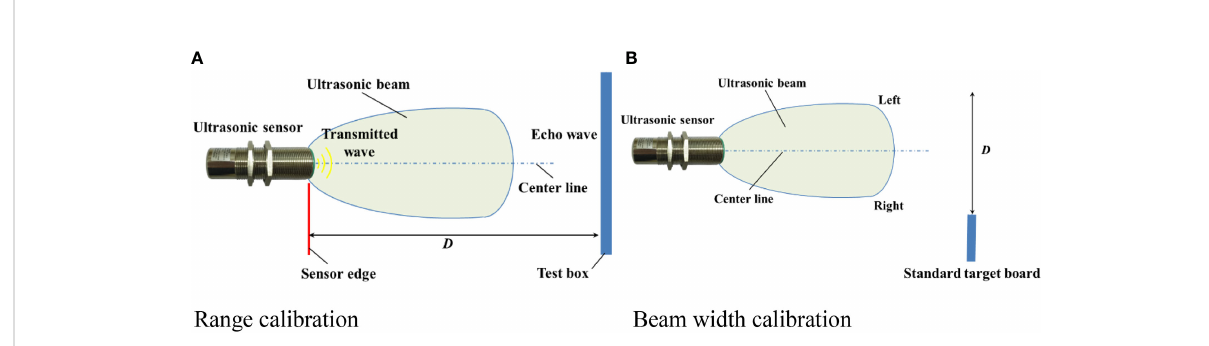
FIGURE 5 Schematic diagram of ultrasonic sensor beam width calibration. Place the standard re fl ector plate perpendicular to the ultrasonic emission direction, and then move it vertically from the center to both sides. Calibrate the detection range through the test. (A) Range calibration (B) Beam width